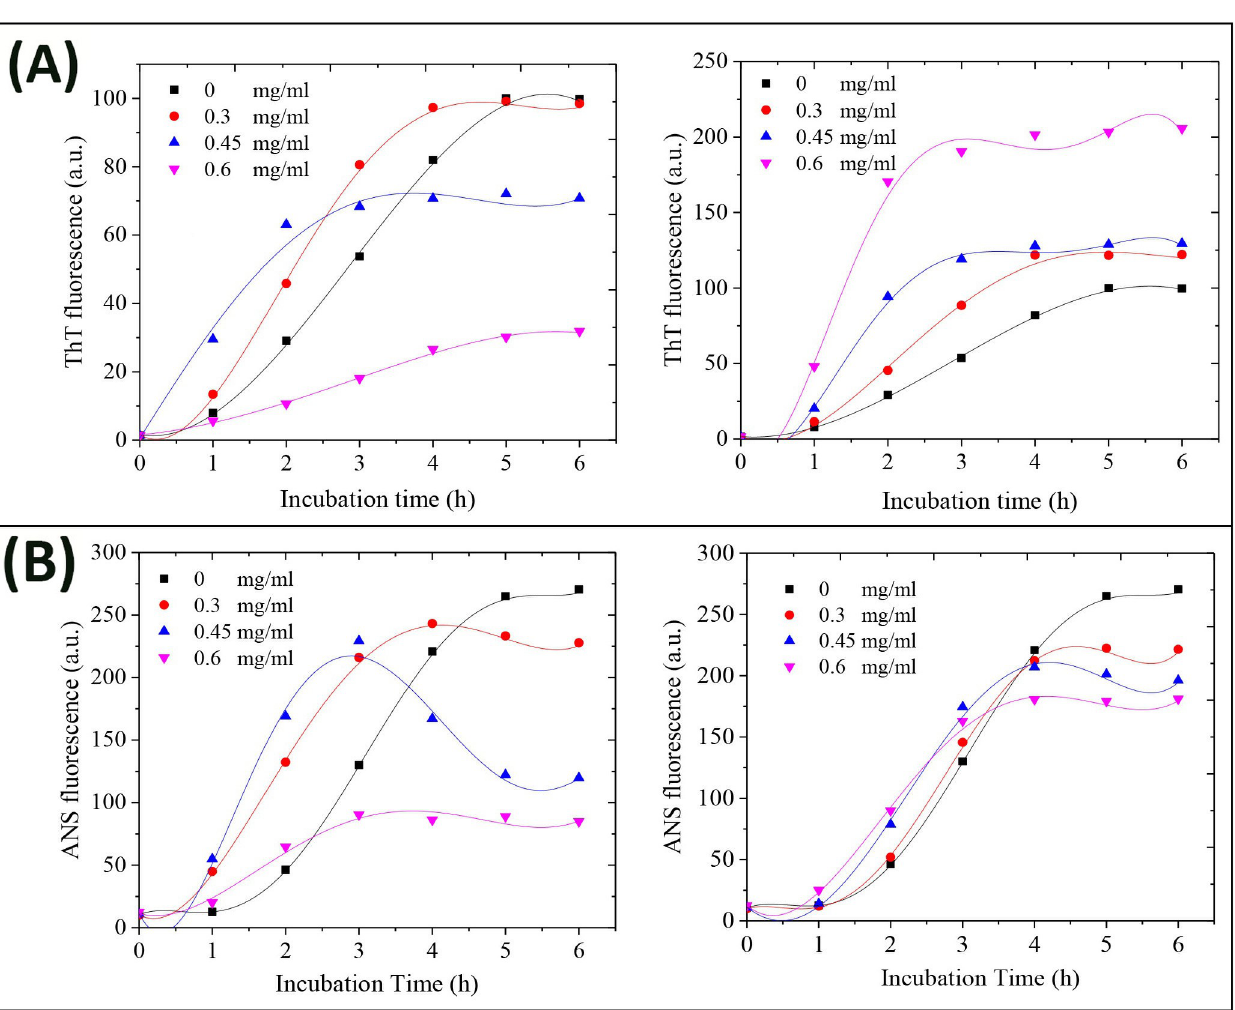
Fig 4. Effect of GOQDs and rGOQDs on the kinetics of amyloid fibrillation (A) and surface hydrophobicity (B) of bovine insulin as monitored by ThT and ANS fluorescence assays, respectively. Protein samples (100 μ M) were incubated in H 2 O/HCl solution (pH 1.5) at 57 � C either alone or with various concentrations of GOQDs (left graphs) or rGOQDs (right graphs) and fluorescence intensity was measured for 6 h. Each experiment was performed in triplicate.